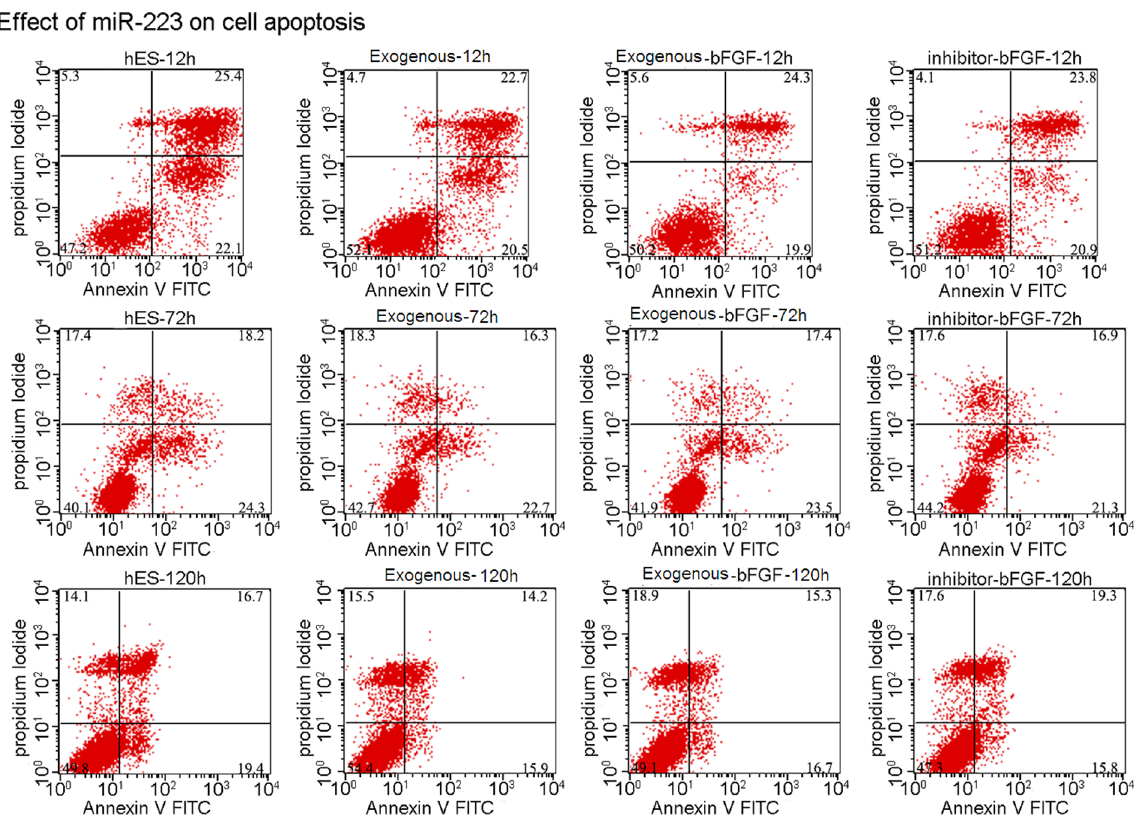
Figure 5. Effects of exogenous miR-223 on cell apoptosis. Cell apoptosis for the indicated groups were assayed by flow cytometry 12 h, 72 h, and 120 h after the withdrawal of bFGF (n=3). Cells were stained with AnnexinV and PI. FACS analysis shows that exogenous expression of miR-223, or an inhibitor of miR-223, does not affect cell apoptosis. The values shown are from experiments performed in triplicate 6 SD.